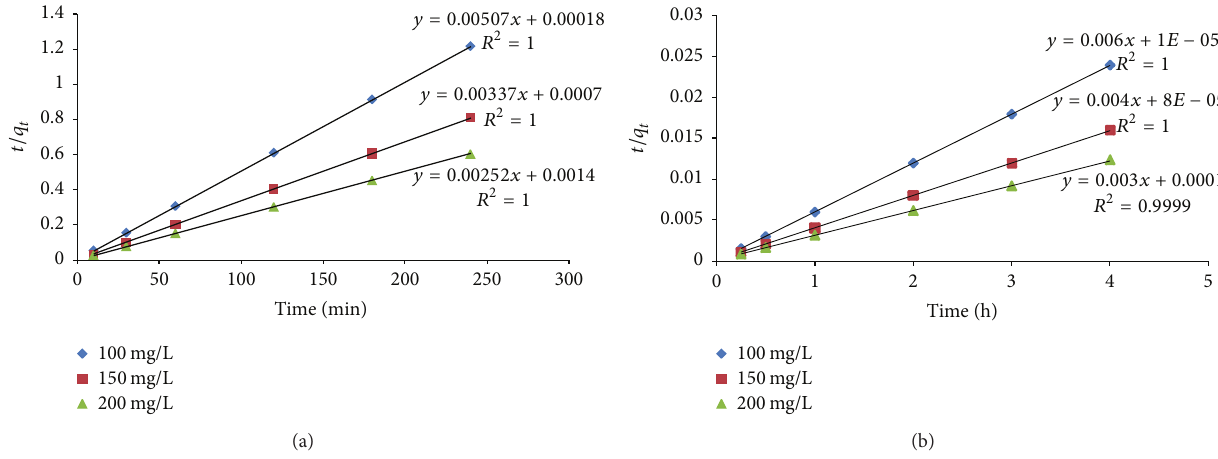
Figure 9: Linear plots of 𝑡/𝑞 𝑡 versus time 𝑡 for different MB concentrations of OMCs-S (a) and OMCs-H (b).